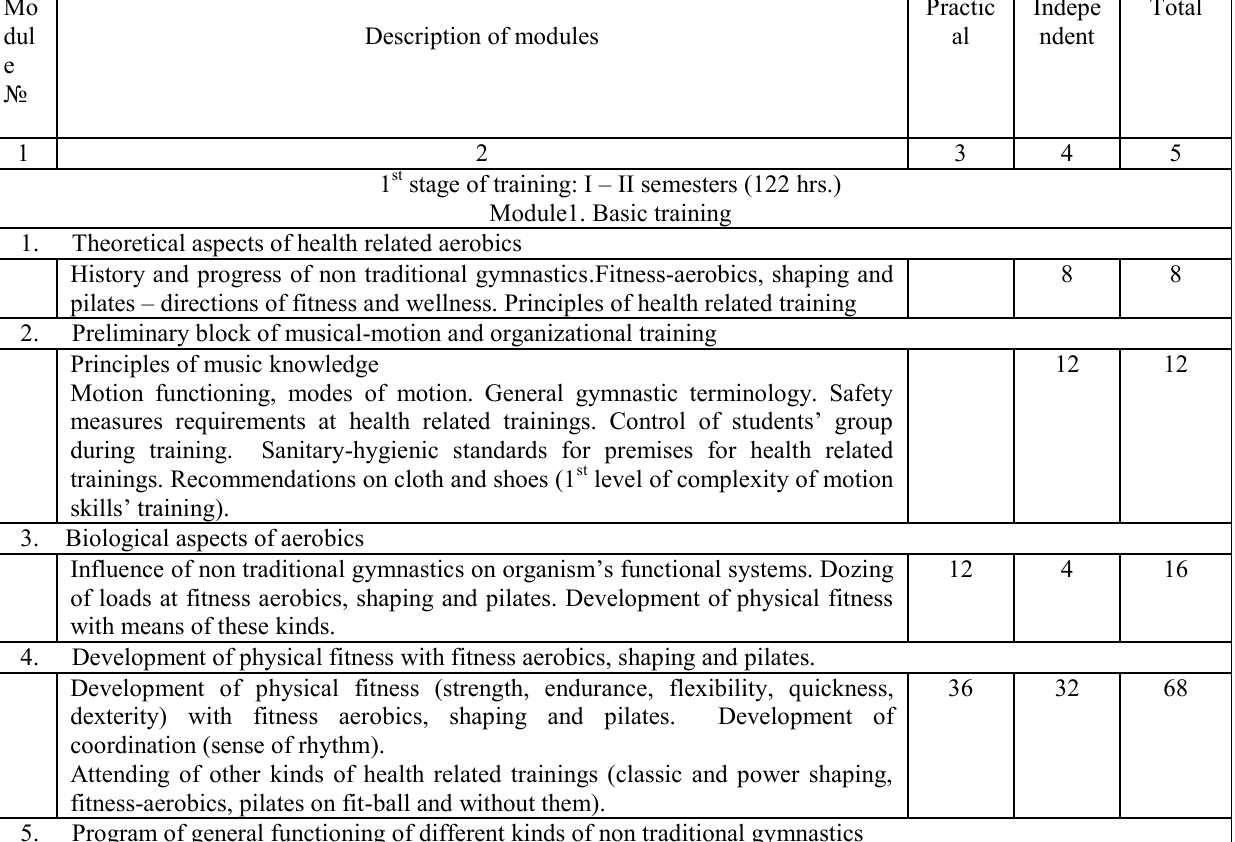
Structure of experimental program